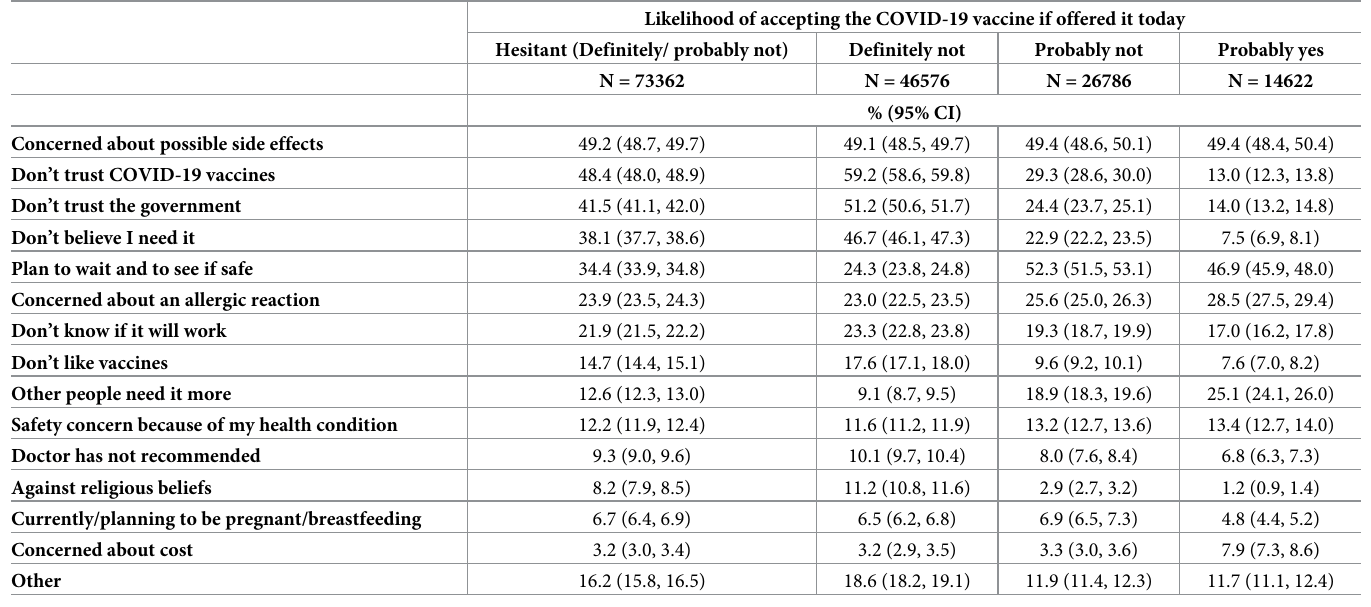
Table 3. Reasons for not getting the COVID-19 vaccine in May, 2021, by vaccine intent level among US adults (N = 87,984) a